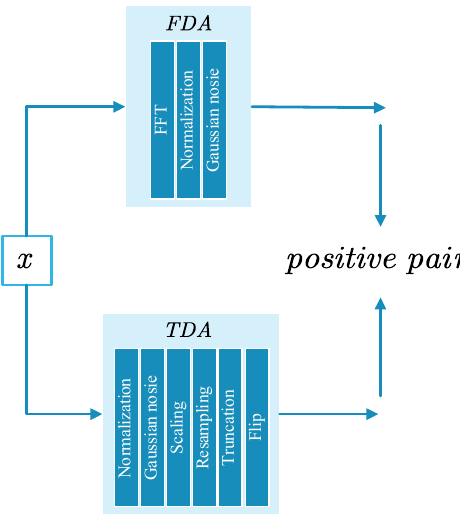
Figure 4. Signal multimodal learning (SML).